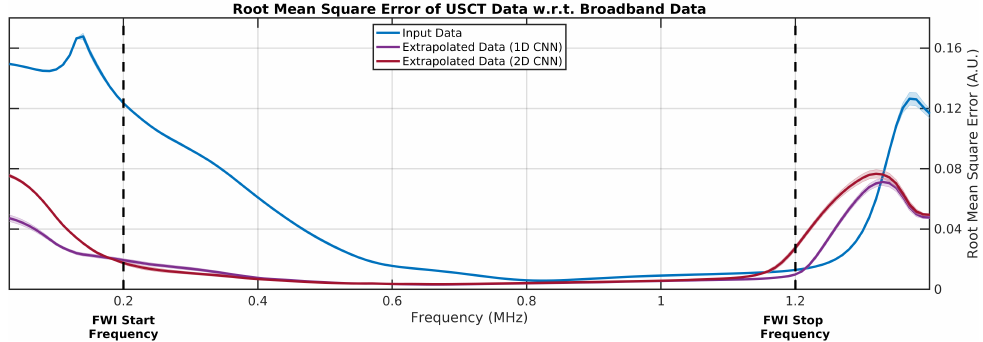
Figure 4. Root-mean-square (RMS) error of synthetic breast USCT data with respect to ideal broad- band data with frequency. Error measurements calculated at different frequency bands by applying an FIR band-pass filter to sample USCT signal data within a 50 kHz wide sliding window centred at frequencies in the range of 0.03–1.50 MHz. Trend lines represent mean RMS error observed for USCT data generated for all 15 testing breast models; shaded area at each trend line represents observed error within these measurements. FWI starting and stopping frequency limits were assigned to be 0.20 and 1.20 MHz, respectively, from observing that extrapolated data tended to closely match the ideal broadband data in this frequency range, as indicated by the low error